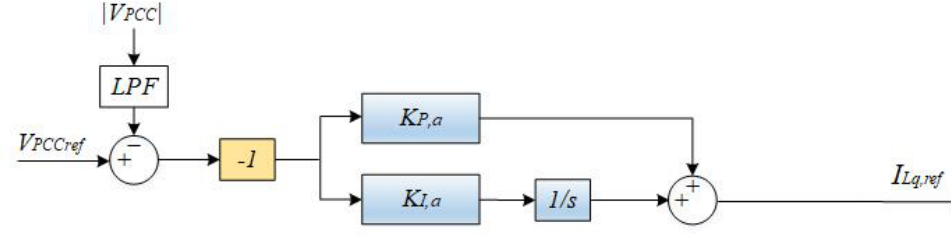
Figure 5. Control structure of the alternate voltage controller (AVC) in Figure